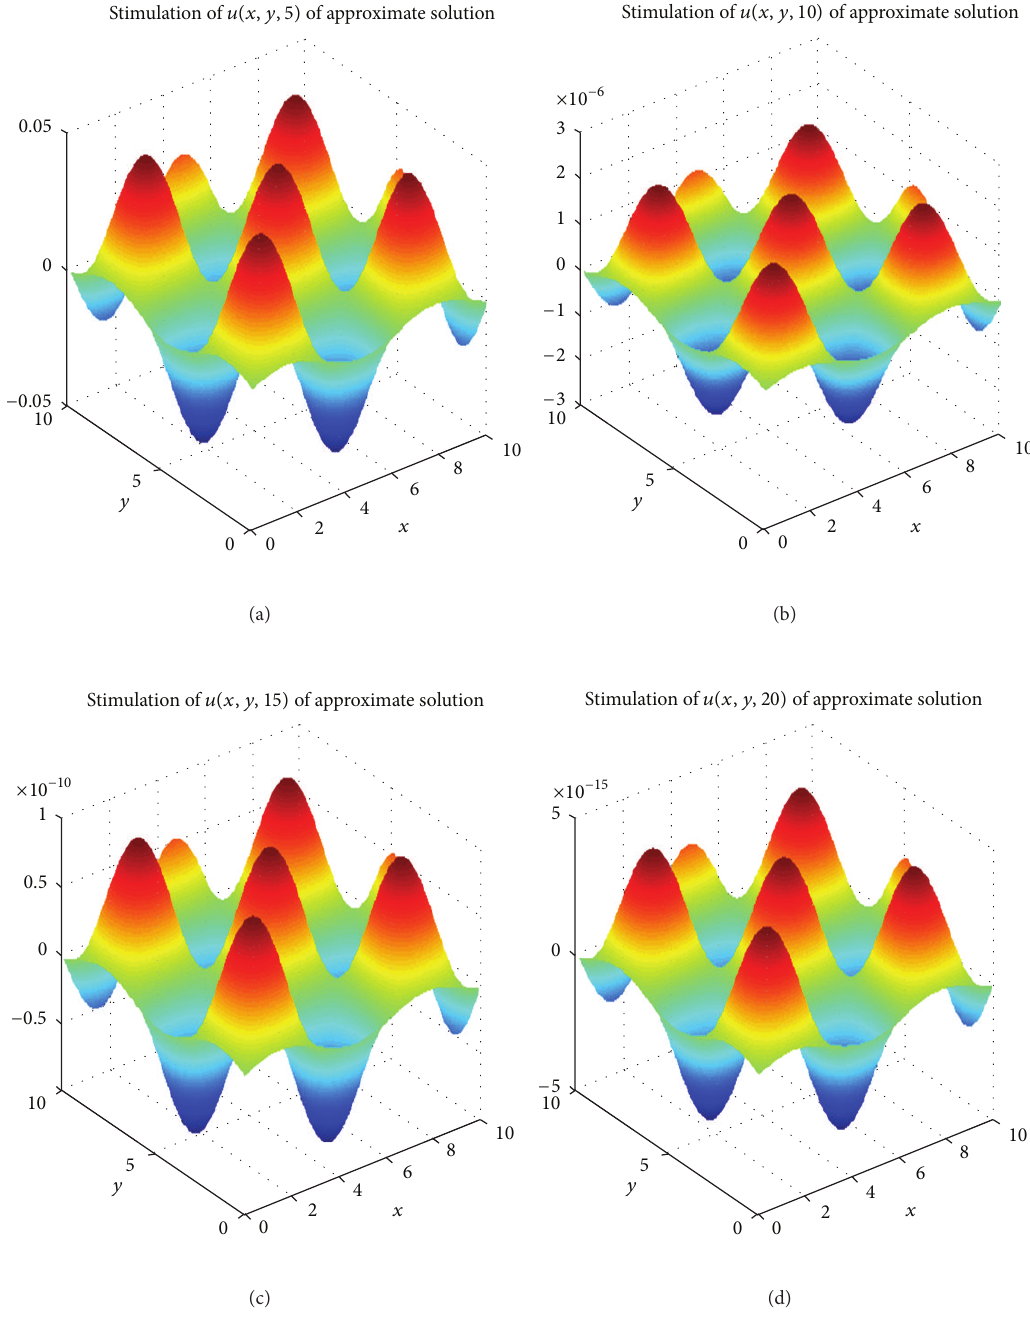
Figure 2: Numerical simulations of the approximate solution of (42) for a fixed 𝑡